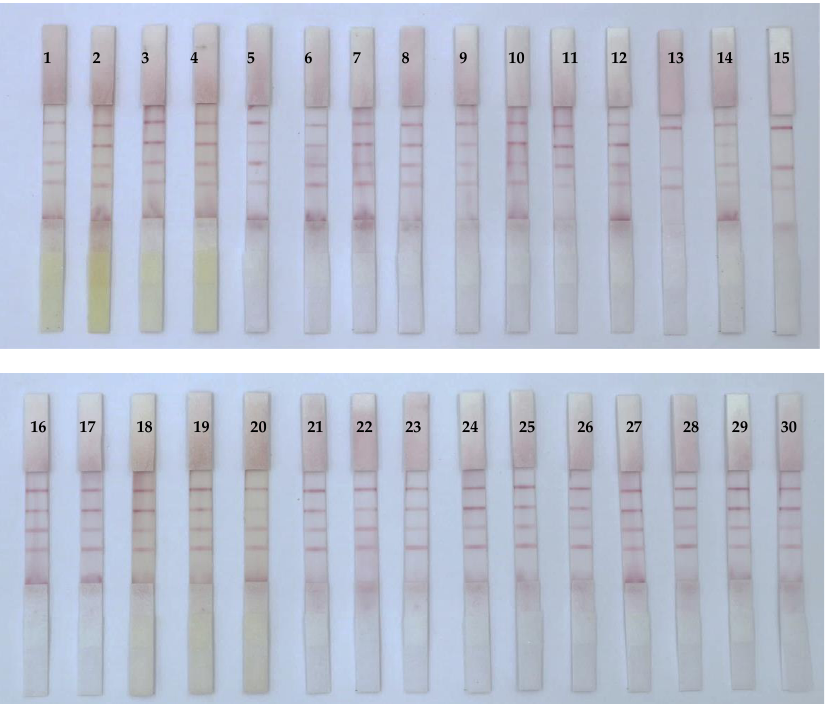
Figure 8. Simultaneous detection of AFB 1 , ZEN, and T-2 in various samples using immunochromatographic strip (ICS).